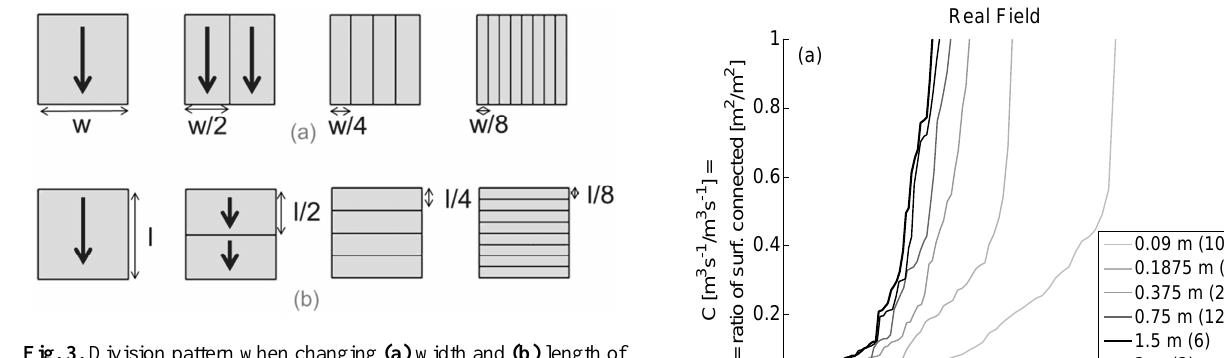
Fig. 3. Division pattern when changing (a) width and (b) length of Figure 3: Division pattern when changing (a) width and (b) length of the plots. 2 the plots. Table 2. Parameters of Eq. (1) when changing width ( w ), good- ness of fit expressed as the sum of squares (SS) and the pseudo R -squared, and representative width for the four microtopography types.